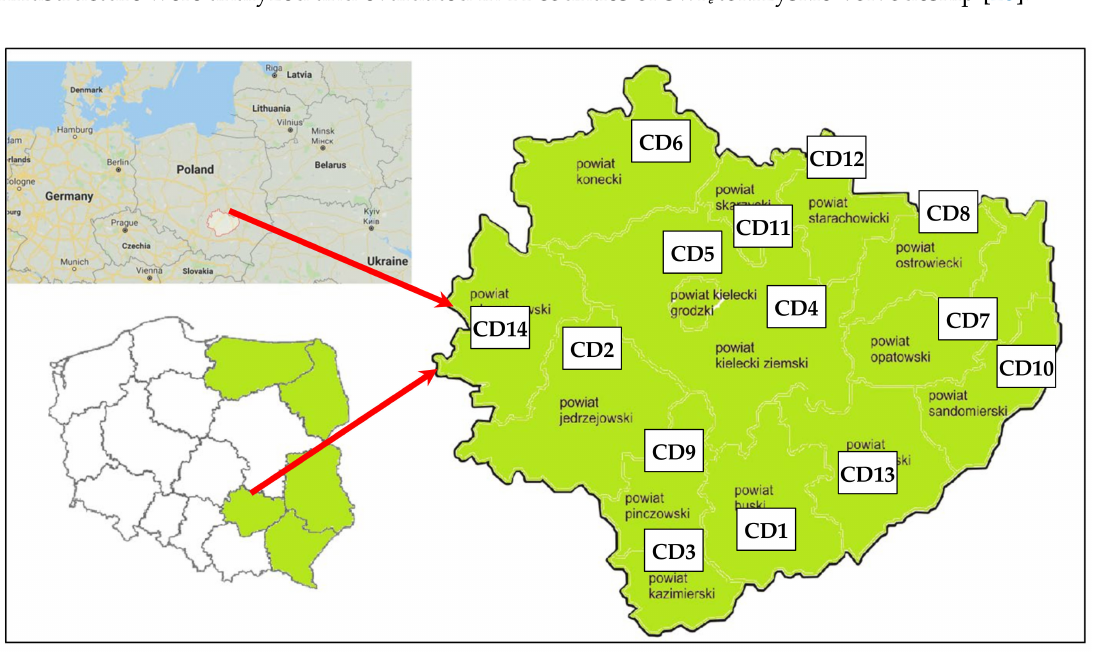
Figure 2. General location of ´Swi˛etokrzyskie Voivodeship. Source: Own